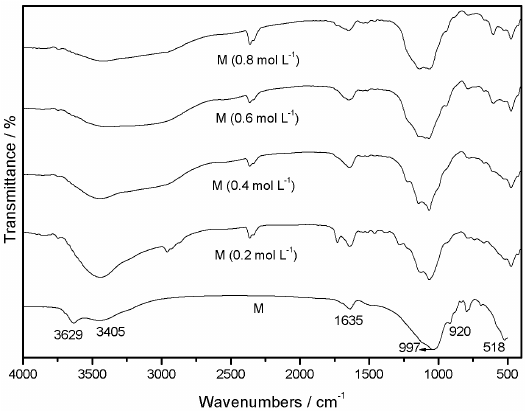
Figure 1. Infrared spectra of treated montmorillonite clay with sulfuric acid at different